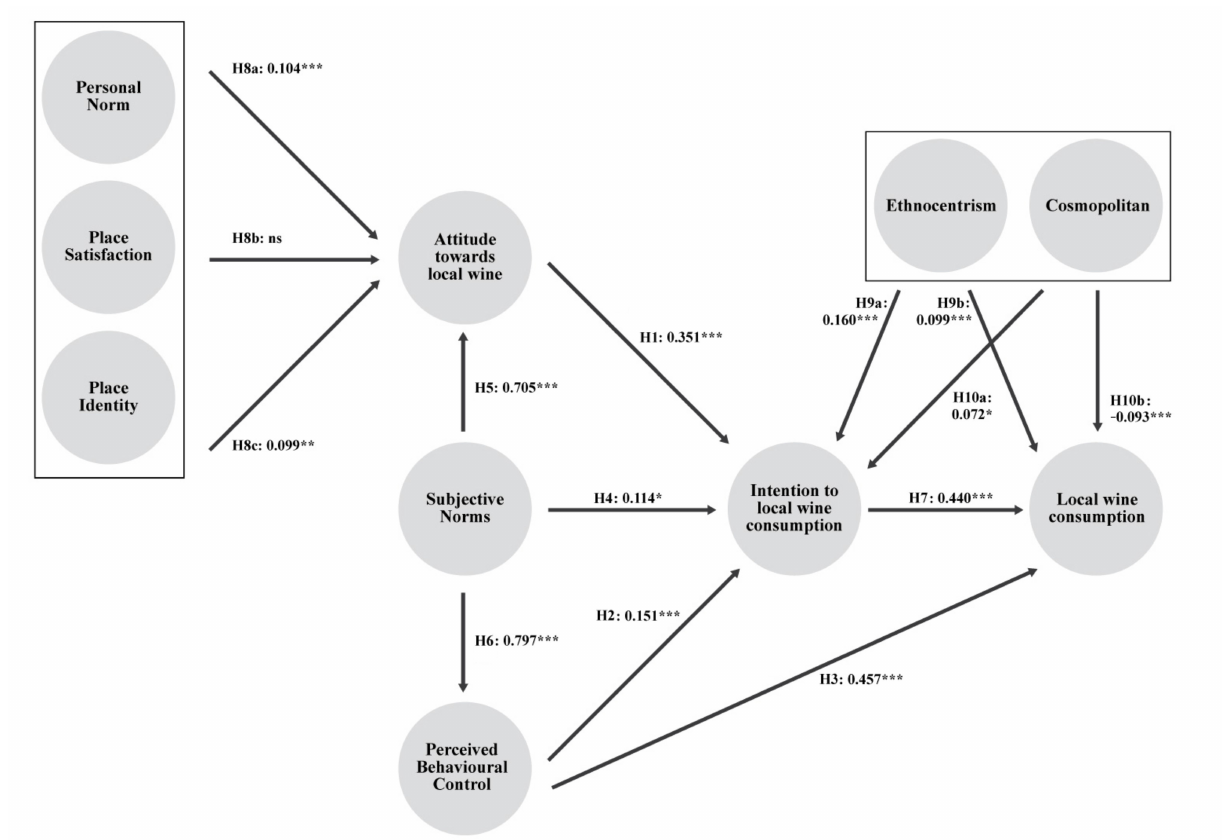
Figure 2. Results of the analysis. Significance level: * p < 0.5; ** p < 0.1; ***; p < 0.01; ns: